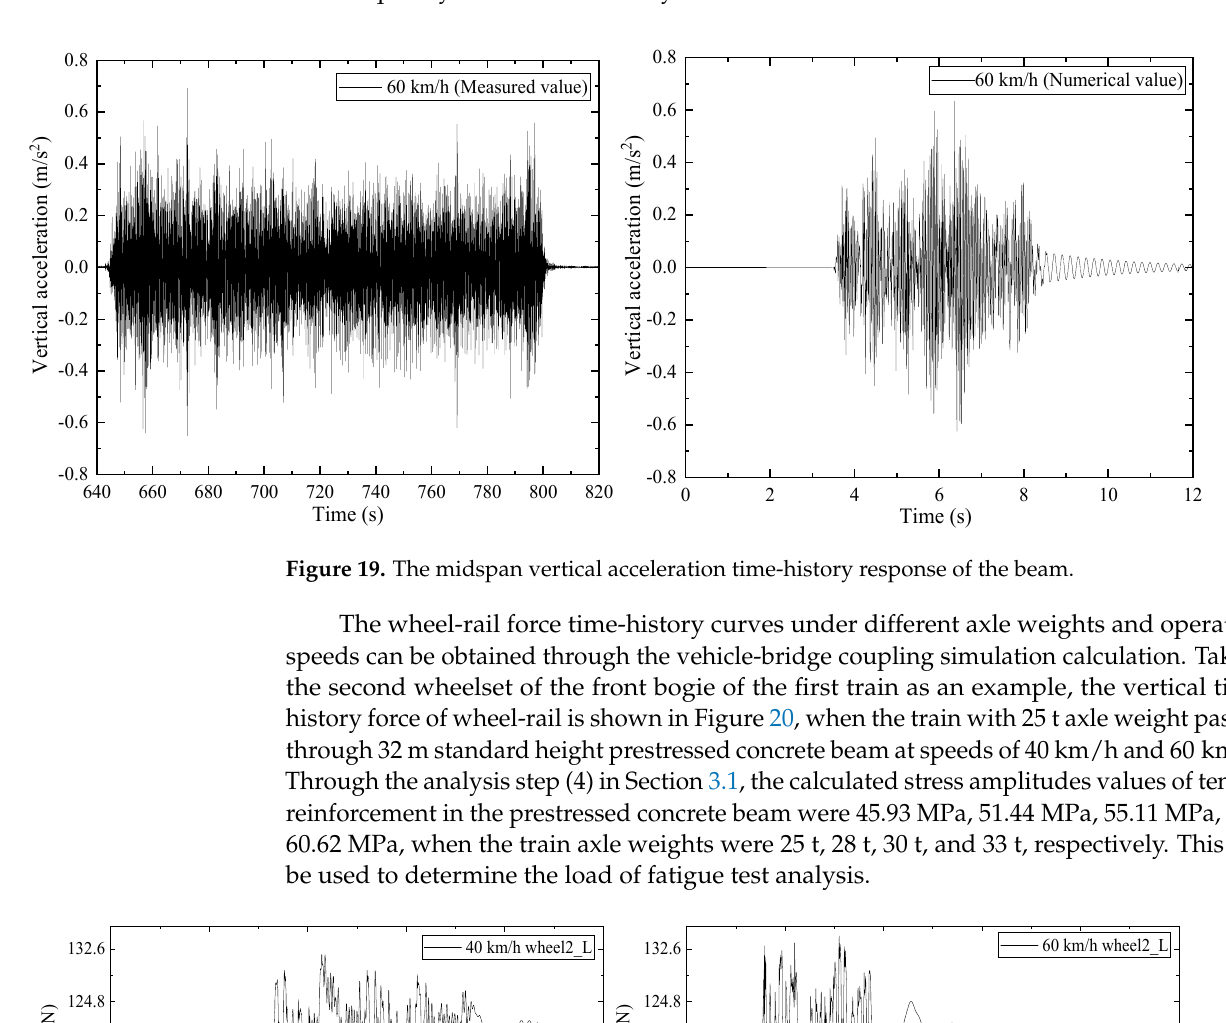
0.6349 m/s 2 , respectively. The vertical acceleration simulation value was slightly different from the measured value. However, it was still also within the fluctuation range, indicating can adequately reflect the actual dynamic characteristics of the structure.